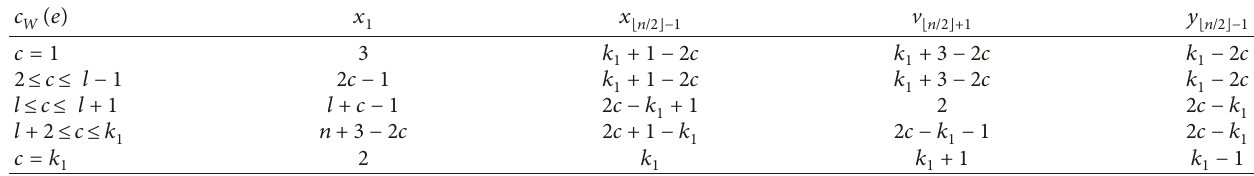
y c is odd. c c , when